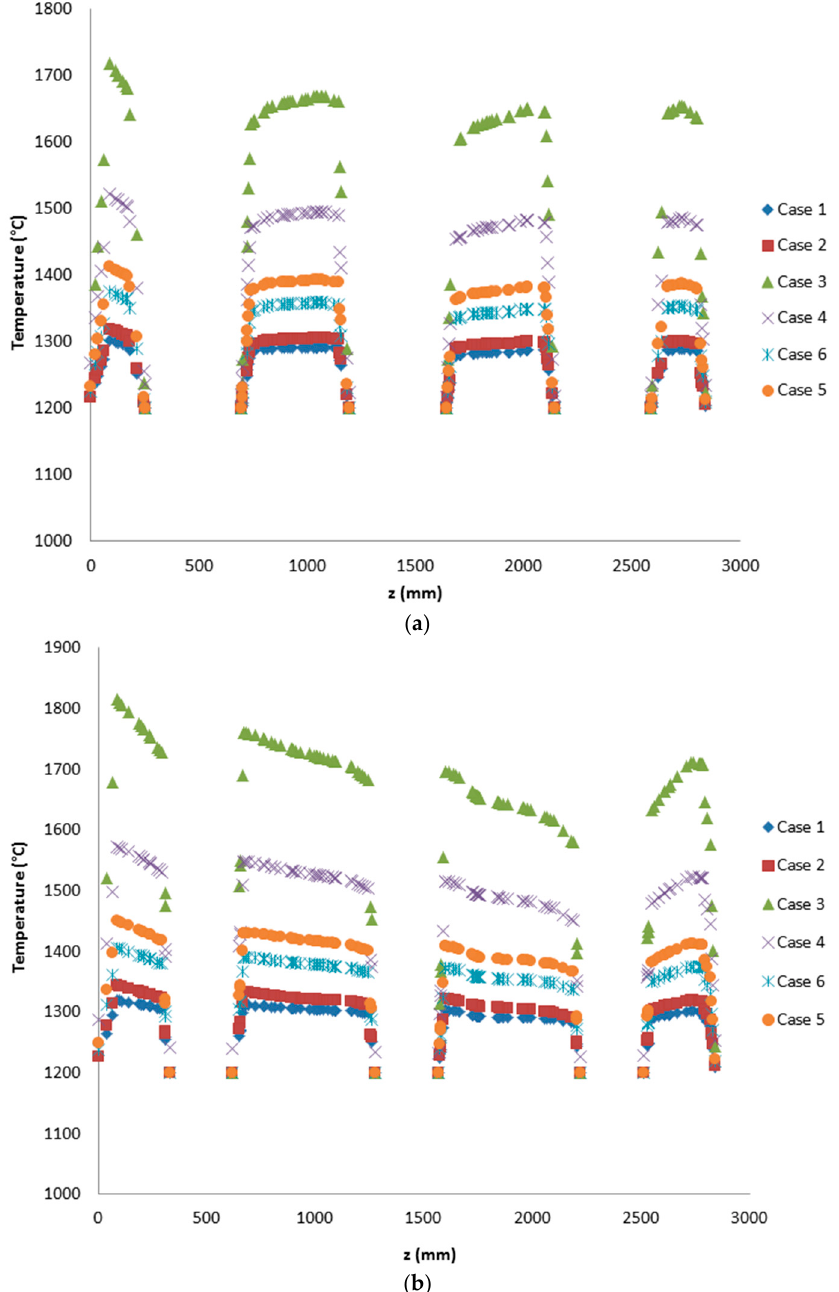
Figure 6. Temperature profile on z - x axis inside the furnace for all six studied cases: ( a ) High level with y = 2093; ( b ) Low level with y = 1093.